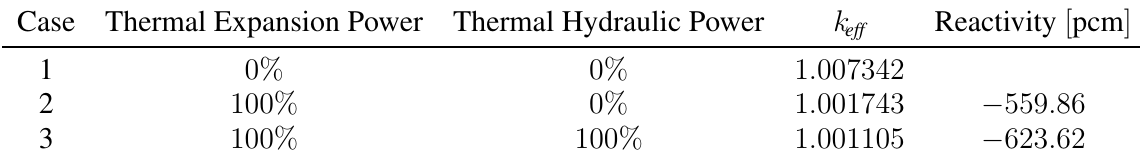
Table 2: Multiphysics Contributions to Total Power